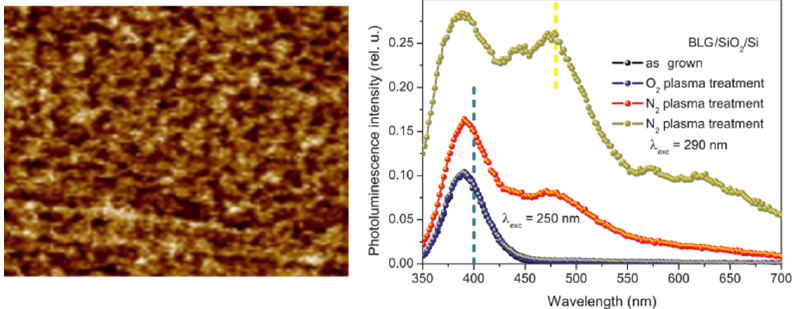
Figure 11. AFM image ( left ) of two graphene layers transferred onto a SiO 2 /Si substrate and processed in nitrogen plasma (scan size 600 × 600 nm 2 ), and photoluminescence spectra ( right ) obtained by excitation of the resulting structure with light with λ exc = 250 nm or 290 nm [29]. A hybrid structure consisting of zero-dimensional (0D) GQD and 2D MoS 2 has demon- strated remarkable properties for optoelectronic devices, outperforming MoS 2 photodetec- tors [31]. GQDs have unique optoelectronic characteristics such as long carrier lifetimes and fast electron-extraction due to huge transition energies and weak coupling to exciton states. When GQDs interact with 2D materials, quantum effects can influence the dynamics of charge carriers, enabling the efficient separation, transport, and collection of charge carriers. Hybrid GQD/MoS 2 photodetectors are shown in Figure 12.